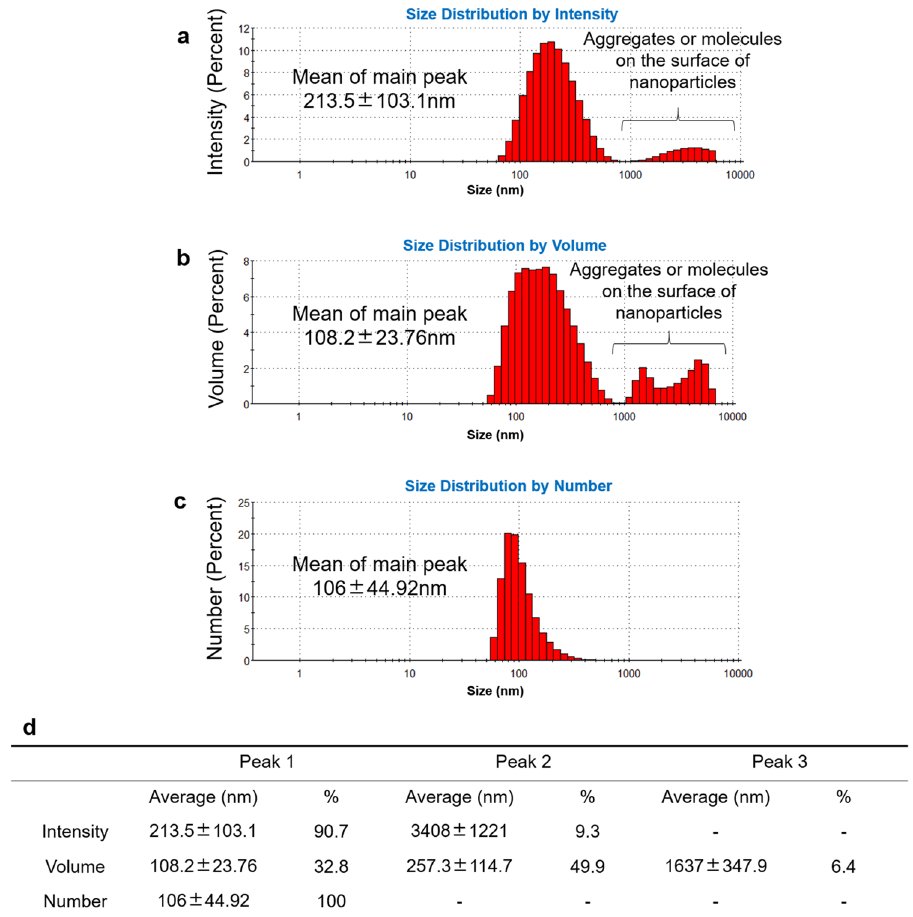
Fig. 4 Measurement of the diameter of GDEs based on size distribution using the dynamic light scattering technique. a – c measurement of size distribution of GDEs by intensity, volume, and number. d particle size distribution by intensity, volume, and number and the standard and mean deviation of the DLS